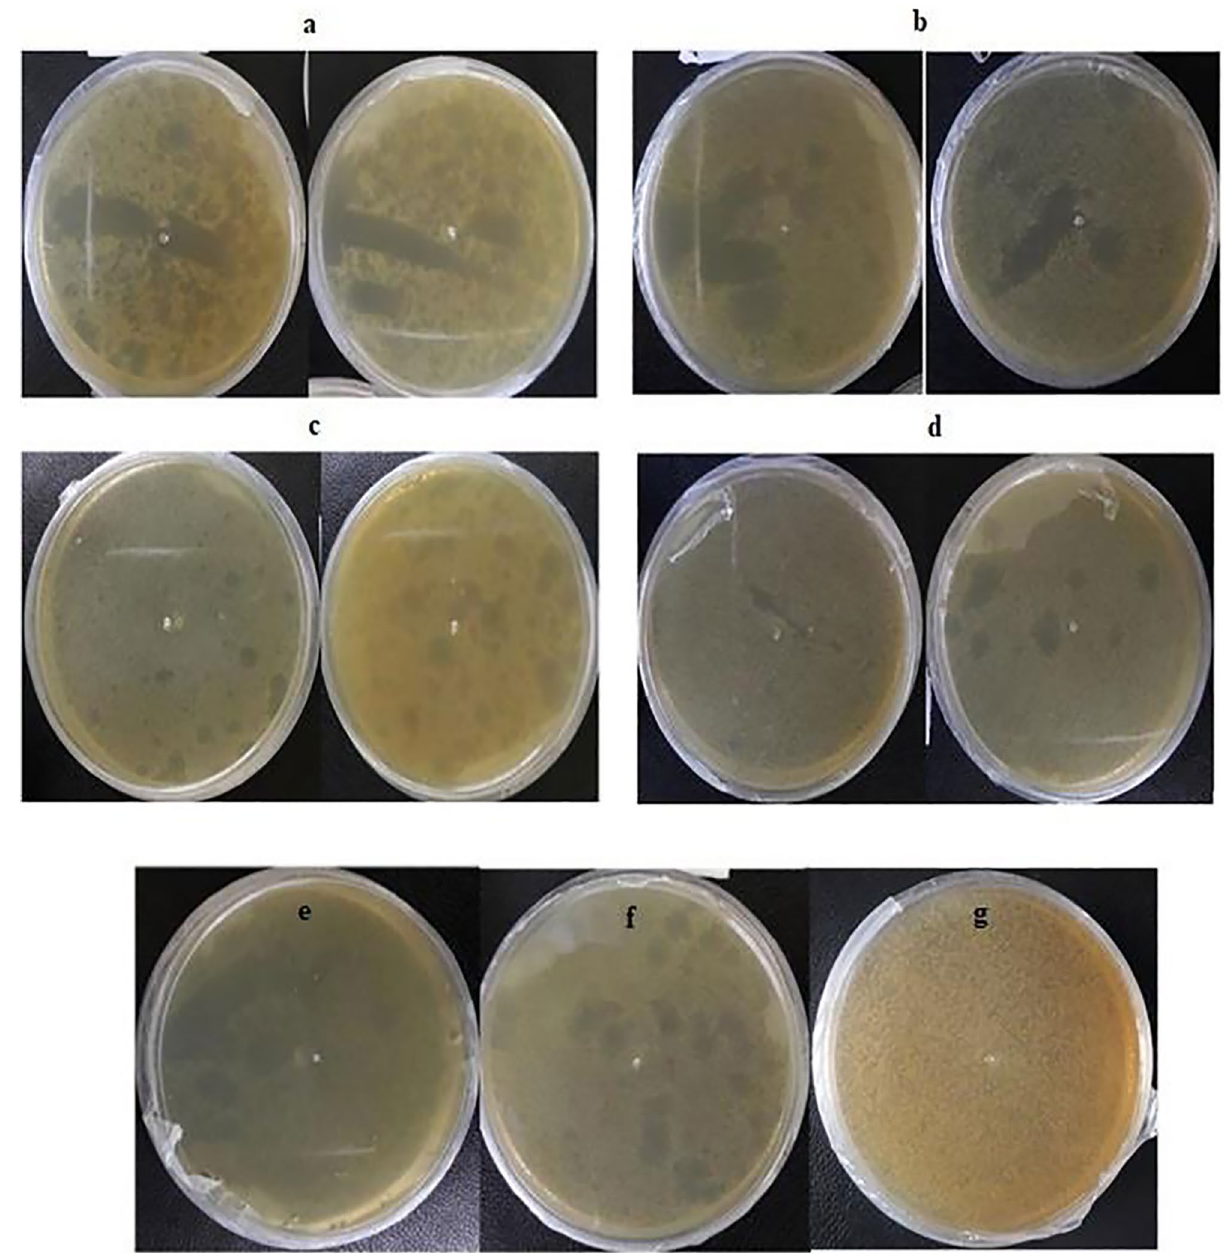
Figure 6. The inhibition of transgenic total protein on bacteriophage, during its pre-treatment with 1:10 and 1:20 dilution of bacteriophage. 2 out of 4 replications are shown for each test (Table 2). ( a ) Pre-treatment of 1:10 diluted bacteriophage with transgenic total protein for 3 h at 37 °C, and consequently adding 30 μL of E. coli . then the symptom observation after 24 h. ( b ) Pre-treatment of 1:10 diluted bacteriophage with transgenic total protein for 24 h at 37 °C, and consequently adding of 30 μL of E. coli , then the symptom observation after 24 h. ( c ) Pre-treatment of 1:20 diluted bacteriophage with transgenic total protein for 3 h at 37 °C, and consequently adding 30 μL of E. coli ,then the symptom observation after 24 h. ( d ) Pre-treatment of 1:20 diluted bacteriophage with transgenic total protein for 24 h at 37 °C, and consequently adding 30 μL of E. coli ,then the symptom observation after 24 h. ( e ) 1:20 diluted bacteriophage, without protein, added to the bacterial environment (negative control). ( f ) Pre-treatment of 1:20 diluted bacteriophage with non-transgenic total protein for 24 h at 37 °C, and consequently adding 30 μL of E. coli , then the symptom observation after 24 h (the 3-h pre-treatment was conducted with the same results as (negative control). ( g ) E. coli growth’s pattern (negative